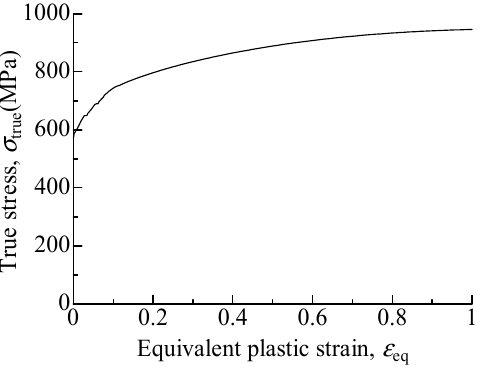
Figure 12. The true stress-equivalent plastic strain curve obtained by PLT method.